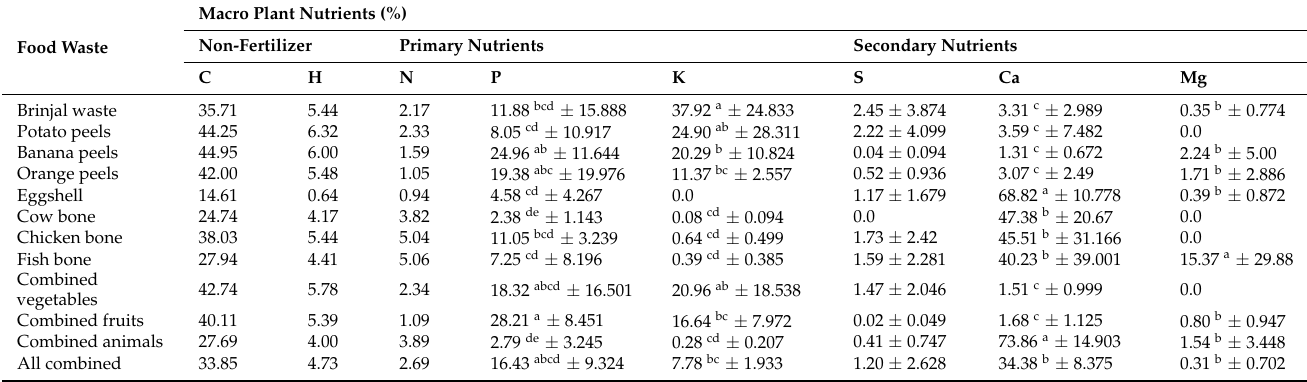
Table 2. Macro plant nutrient content of different food